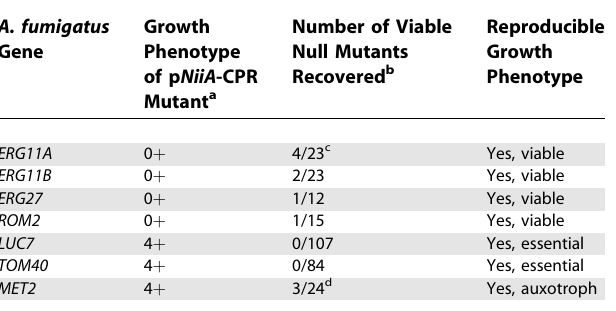
Table 1. Comparison of Growth Phenotypes Observed by p NiiA -